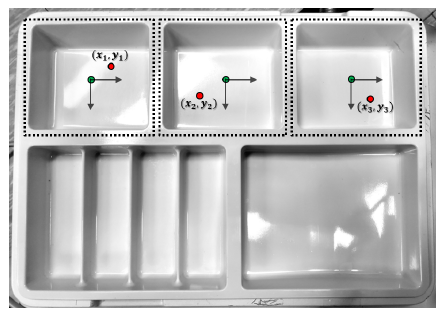
Figure 8. Relative coordinates for each cell